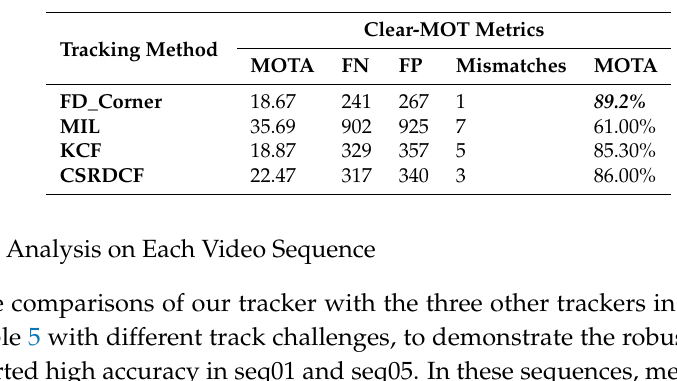
Table 4. Comparison of the baseline and stare of art trackers with frame difference (FD) Corner: Clear-MOT evaluation measurement on the entire video